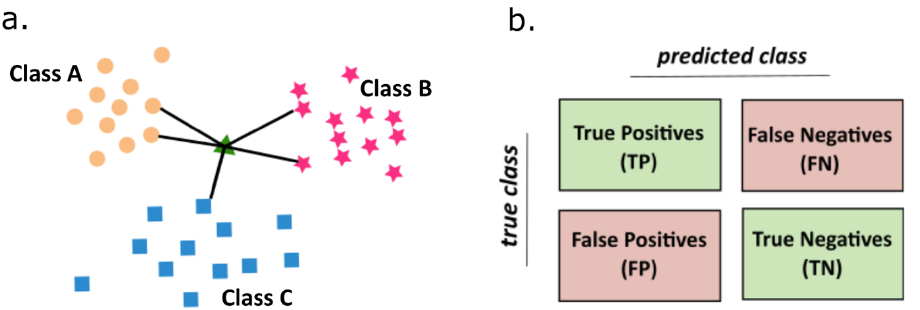
Figure 8. ( a ) Representation of K-nearest neighbors algorithm: general scheme of algorithm, ( b ) illus- tration of confusion